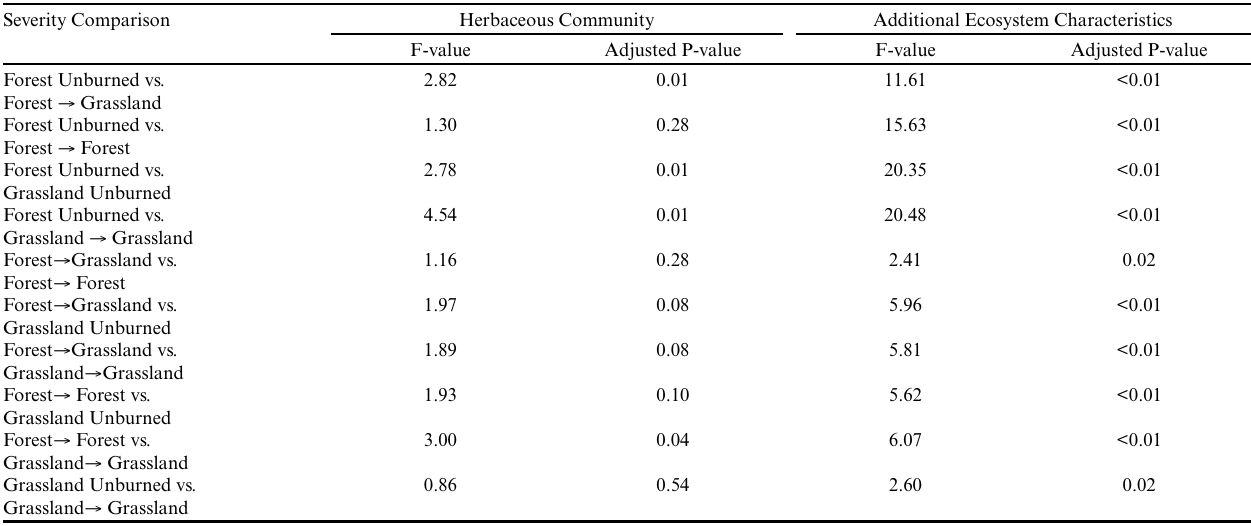
Table 1 . Multiple PERMANOVA comparisons of forest stand structure, bird community, understory woody plant community, and herbaceous community data collected in 2015 and 2016 from sites within and surrounding the perimeter of the 1989 Fort Robinson wildfire, Nebraska, USA. Sites were categorized by transition class. The first column heading describes the comparison among transition classes, “Herbaceous Community” indicates PERMANOVA outputs comparing herbaceous community among transition classes, and “Additional Ecosystem Characteristics” indicates PERMANOVA outputs comparing forest stand structure, bird community, and understory woody plant